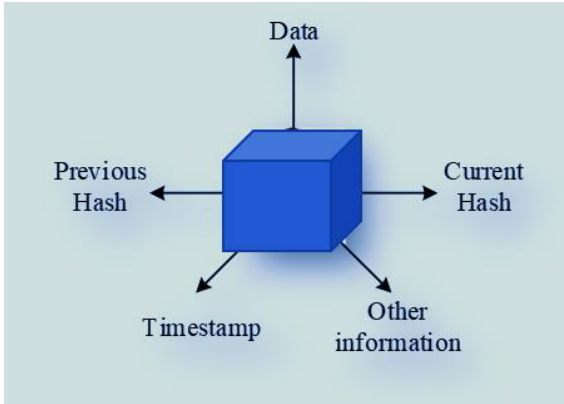
Figure 1. Individual block with its main components.